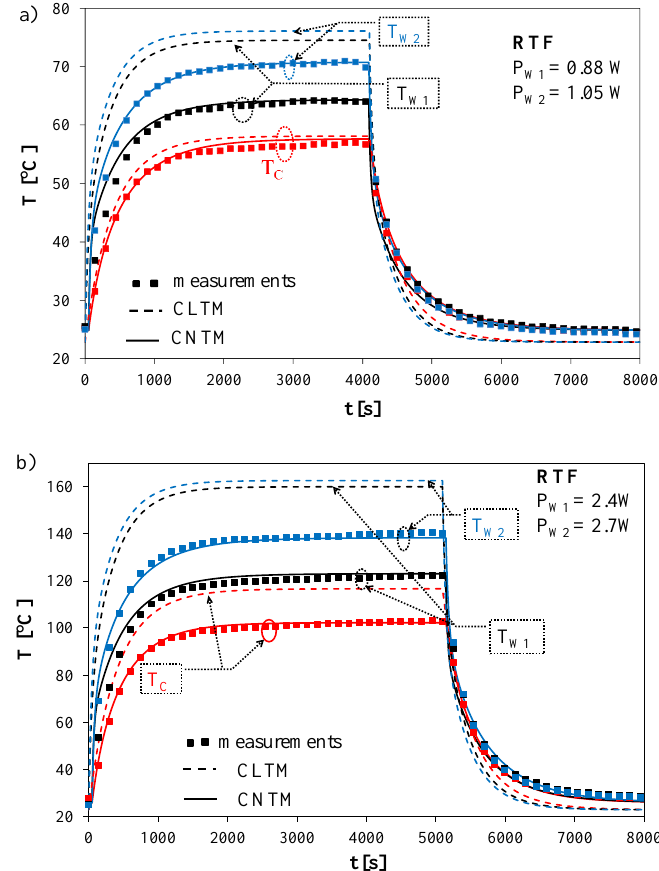
Figure 11. Measured and calculated temperature waveforms of the primary winding T W1 , the secondary winding T W2 and the core T C with simultaneous power dissipation in the windings: ( a ) P W1 = 0.88 W and P W2 = 1.05 W; ( b ) P W1 = 2.4W and P W2 = 2.7 W.